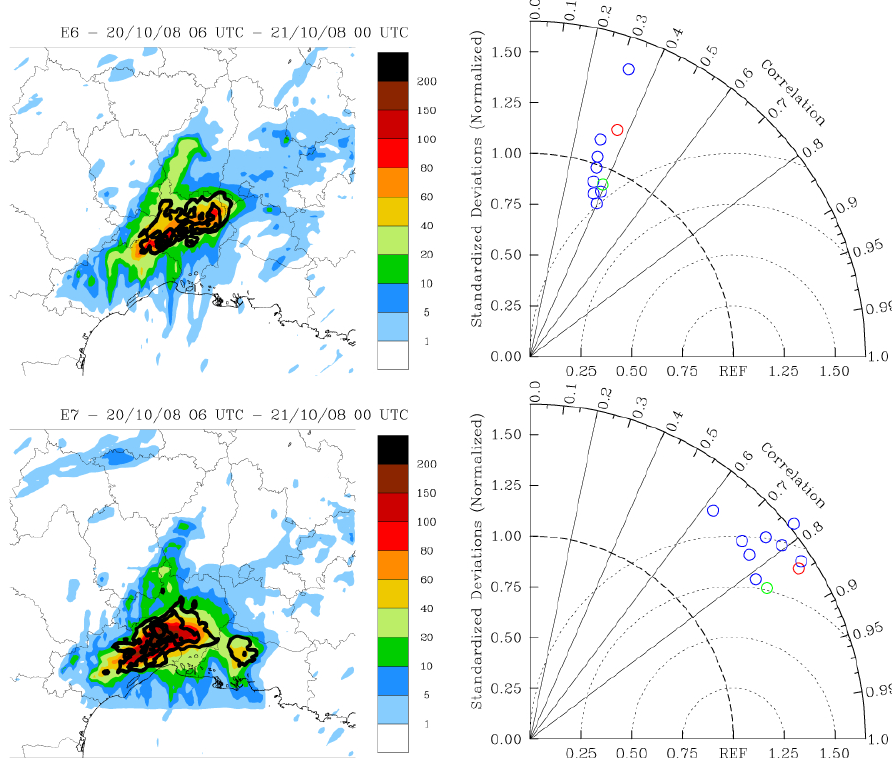
Fig. 16. As Fig. 10 but for the 18-h accumulated precipitation of the E6 and E7 ensembles (Gard-H´erault case).